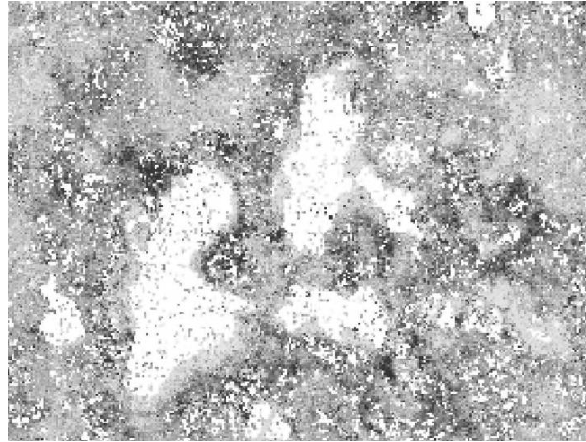
Figure 5. Canopy height model (10 m resolution) derived using